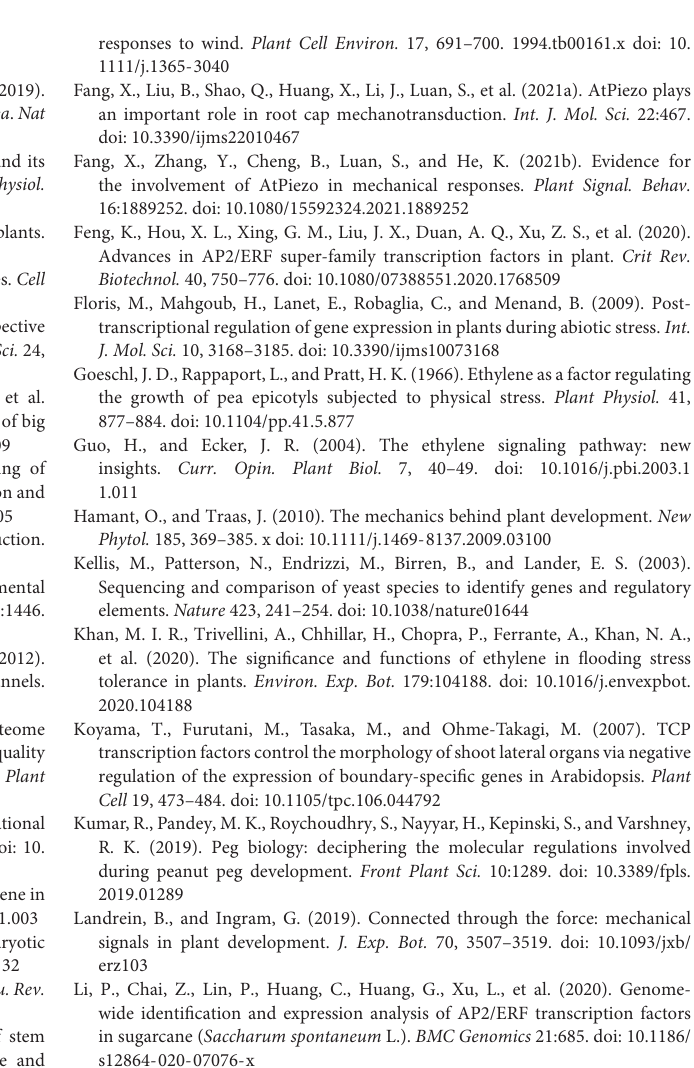
Supplementary Figure 2 | Chromosomal distribution of ethylene sensors, constitutive triple responses ( CTR s), ethylene insensitive 2 ( EIN2 s), ethylene insensitive 3/ethylene insensitive 3-like ( EIN3/EIL s), and EIN3-binding F-box proteins ( EBF s) in Arachis hypogaea ( A. hypogaea ) genome. Supplementary Figure 3 | Gene location and intragenomic collinearity of AhAP2/ERFs. Gray lines indicated all the collinearity in A. hypogaea genome, while colored lines highlighted the collinearity of AhAP2/ERFs.